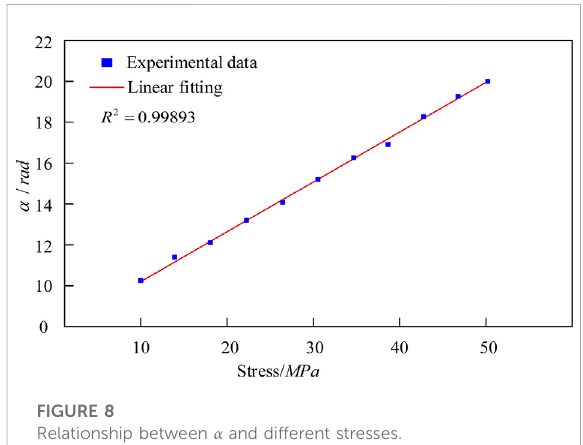
FIGURE 8 Relationship between α and different